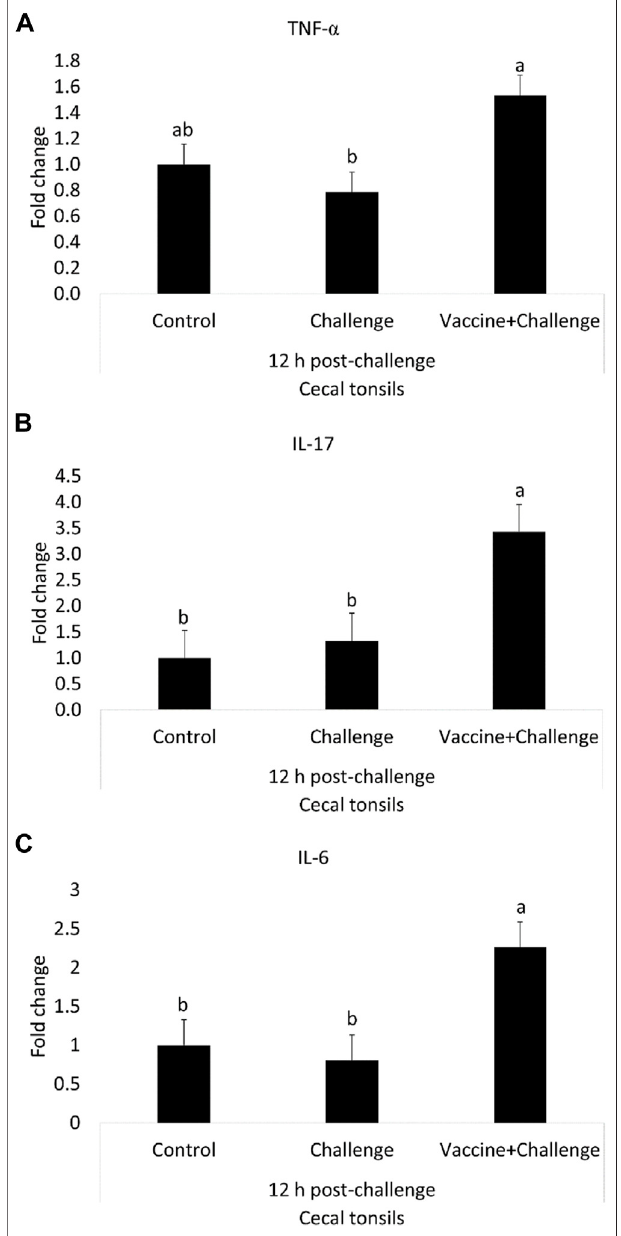
FIGURE4| TheEffectsof Salmonella CNP VaccineonGeneExpression in the Cecal Tonsils of Vaccinated Birds at 12 h post-vaccination. Atd1 ofage birds were allocated into treatment groups: 1) Control; 2) Challenge; or 3) Vaccine + Challenge. At d1 and d7 of age birds in the negative and positive control groups were mock vaccinated with PBS and birds in the treatmentgroupwerevaccinatedwithCNP.Atd14ofagebirdsinthenegative controlgroupweregivenamockchallengeof0.5 mlPBS/birdandbirdsinthe positive control and the treatment group were orally challenged with 1 × 10 7 CFU/bird of S . Enteritidis. Cecal tonsils were collected from one bird/pen ( n = 6) at 12 h post-vaccination. Data represented as fold change compared to control. (A) TNF- α mRNA; (B) TLR 5 mRNA; (C) IL-6 mRNA. Bars (+SE) with no common superscript differ ( p < 0.05).